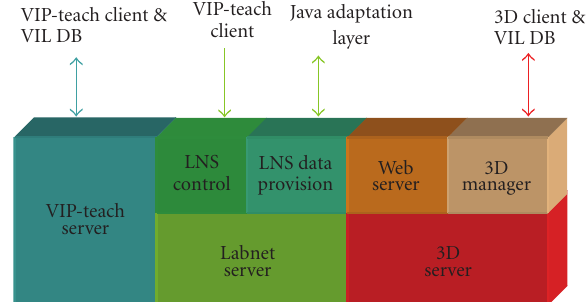
Figure 6: Main components of CEM.